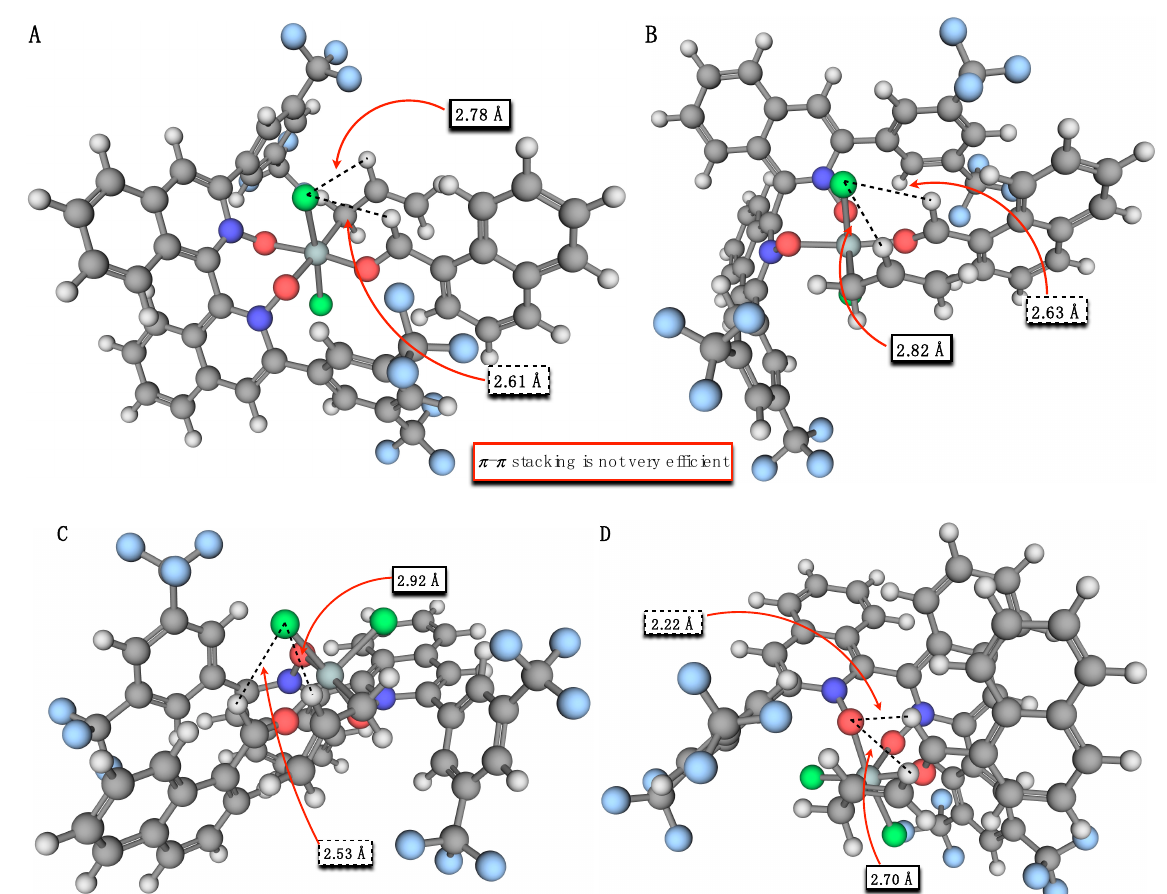
Figure 3. Relevant bond lengths in Trans -1-Chair-Re (panel A ), Trans -1-Chair-Si (panel B ), Cis -2-Chair-Re (panel C ), and Cis -2-Chair-Si (panel D ). The bond distances reported inside a box with a solid border refer to the allylic hydrogen, while the ones inside a box with a dotted border refer to the hydrogen of the aldehyde. The structures have been obtained at the M11/def2-SVP level of theory in acetonitrile (C-PCM).